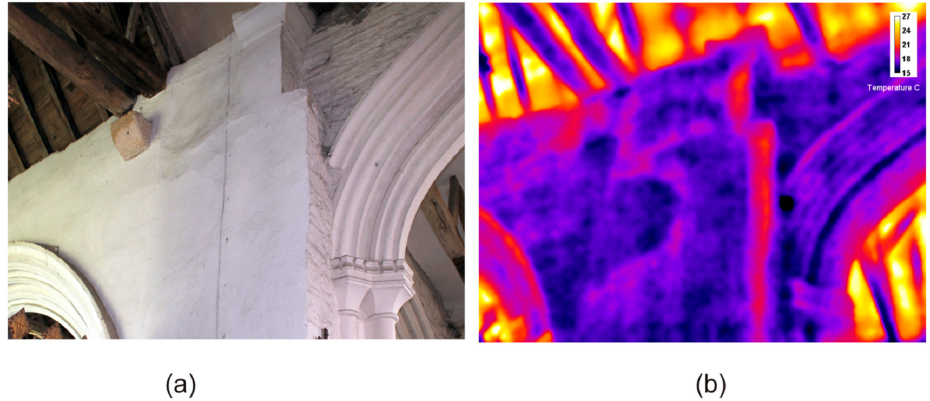
Figure 5. Holme-by-Newark church, Nottinghamshire, U.K. showing the nave/chancel junction on the south side: ( a ) under normal lighting (daylight), as seen by the unaided eye, and ( b ) in the thermal infrared with low level Wallis filtration applied and a custom LUT.